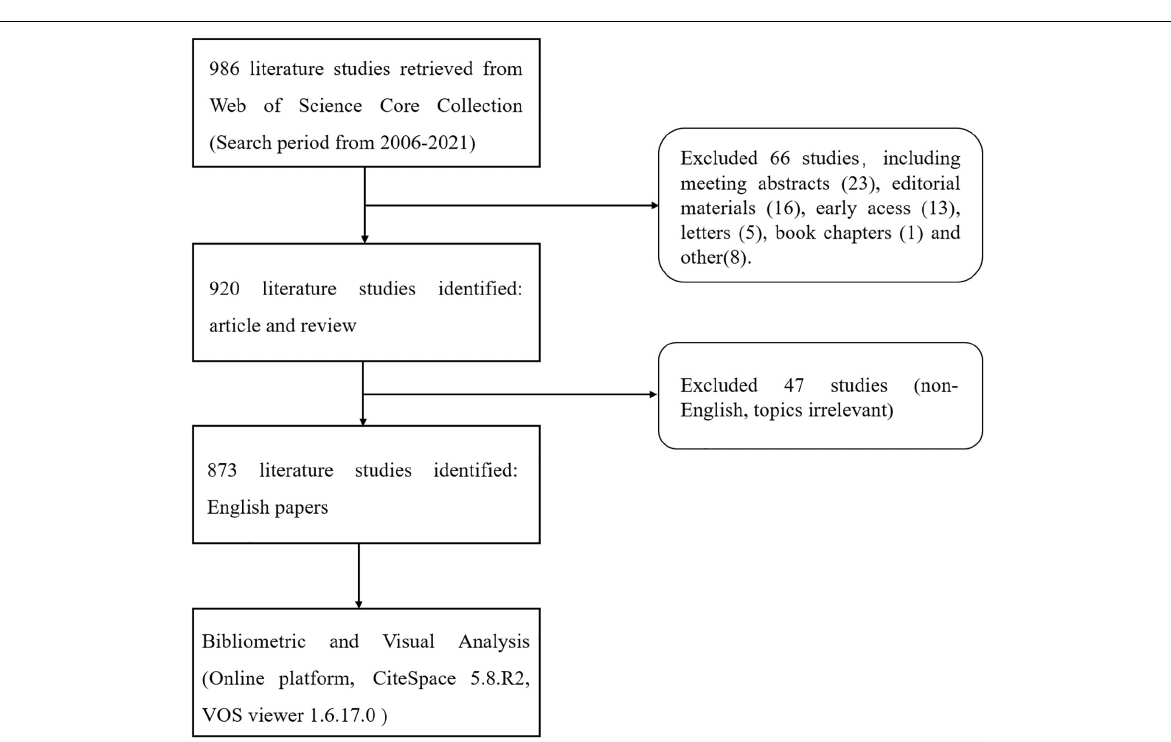
FIGURE 2 | Flowchart of the inclusion and exclusion